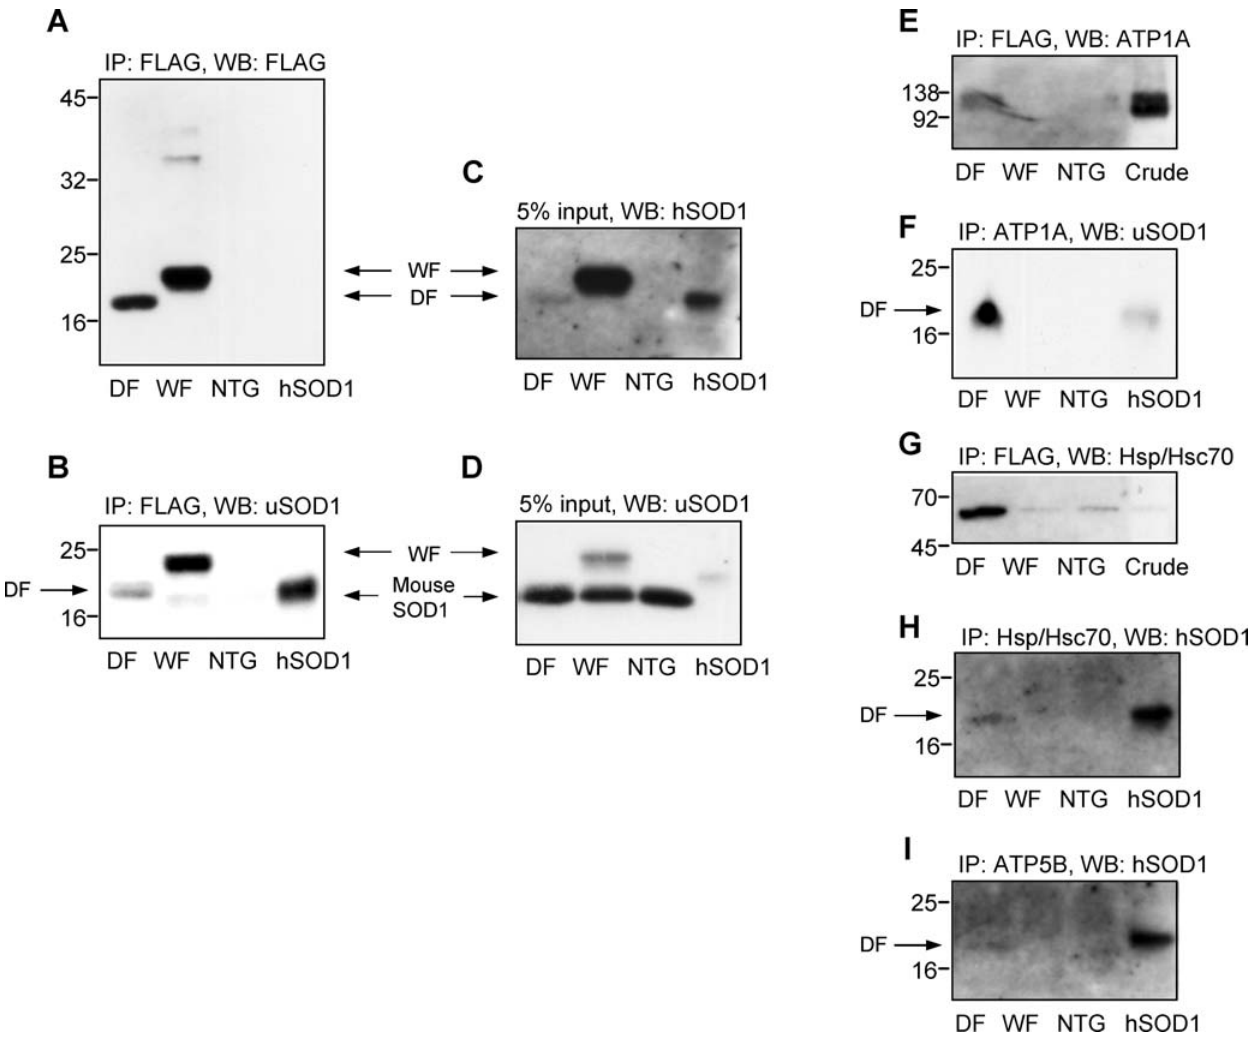
Figure 2. Immunoprecipitation and western blot analyses of mouse spinal cords. The FLAG-tagged SOD1 and the ligand proteins were immunoprecipitated using the FLAG affinity resin and detected by the anti FLAG antibody ( A ) and anti-SOD1 polyclonal antibody (uSOD1) that recognizes both human and mouse SOD1 ( B ). The DF mutant SOD1 shows a distinct single band ( A and B ). In contrast, the WF shows high molecular weight bands ( A ) and a low molecular weight band which is possibly the mouse intrinsic SOD1 ( B ), indicating that the WF forms the heterodimer with the mouse SOD1. Crude spinal cord extracts (5% input) were analyzed using antibodies for human specific SOD1 (hSOD1) ( C ) and for uSOD1 ( D ). Compared to the WF, the amount of the DF SOD1 protein is considerably lower ( C ). The WF itself is lower still compared to the mouse intrinsic SOD1 ( D ). The immunoprecipitation products with the FLAG were analyzed by antibodies for ATP1A ( E ) and Hsp/Hsc70 ( G ). In this analysis, only the DF preparations show the presence of ATP1A ( E ). In the Hsp/Hsc70 analysis in ( G ), there are non-specific precipitations also in WF and NTG. In contrast, the immunoprecipitated samples for ATP1A ( F ), Hsp/Hsc70 ( H ) and ATP5B ( I ) were analyzed using antibodies for hSOD1 ( F ) or uSOD1 ( H and I ). Correspondingly, the human form of SOD1 is only seen to be co-immunoprecipitated in DF preparation ( F , H and I ). Lanes from the left are: DF, WF, NTG, and a purified human SOD1 ( A , B , C , D , F , H , and I ); and DF, WF, NTG, and a crude soluble fraction of NTG mice ( E and G ).